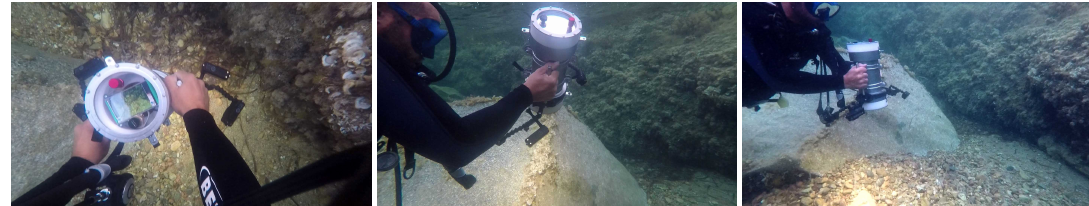
Figure 5. The built handheld stereo system in